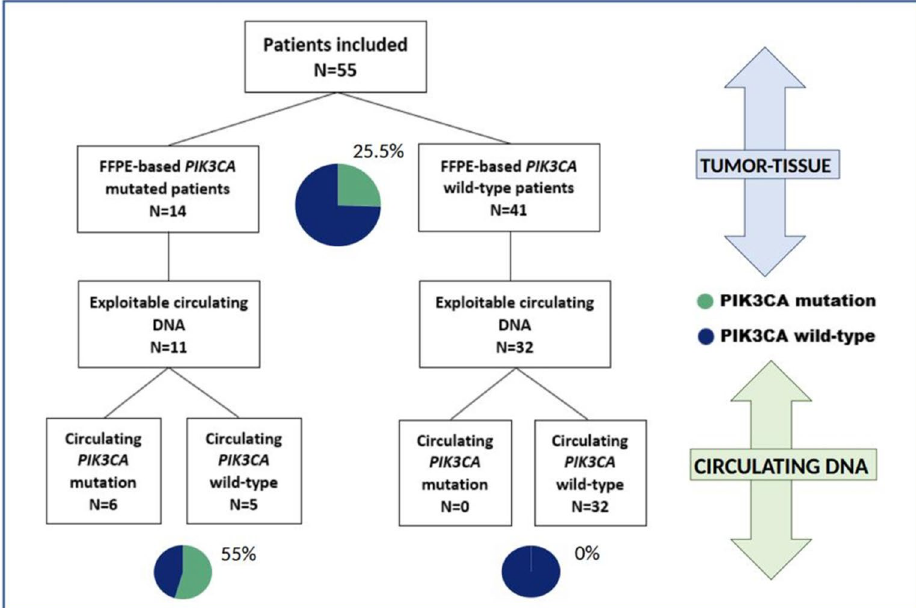
Figure 2. Distribution of FFPE-based and circulating PIK3CA mutation at diagnosis. Among the 55 patients of this cohort, FFPE-based PIK3CA mutation were detected in 14 patients (25.5%); among them, 11 had exploitable circulating DNA, and 6 patients (55%) harboured a corresponding circulating PIK3CA mutation. No other circulating mutation was identified among the 43 patients with fully interpretable circulating and biopsy mutational